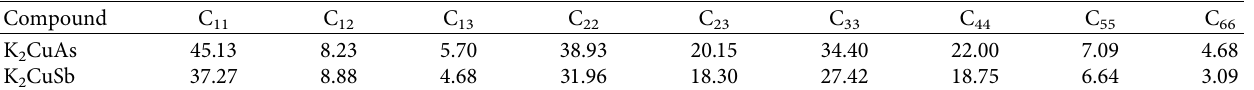
Figure 4: The calculated (a) band structure and (b) PDOS of the K 2 CuSb ternary compound. Table 3: Computed elastic constants C ij (GPa) of K 2 CuAs and K 2 CuSb compounds.